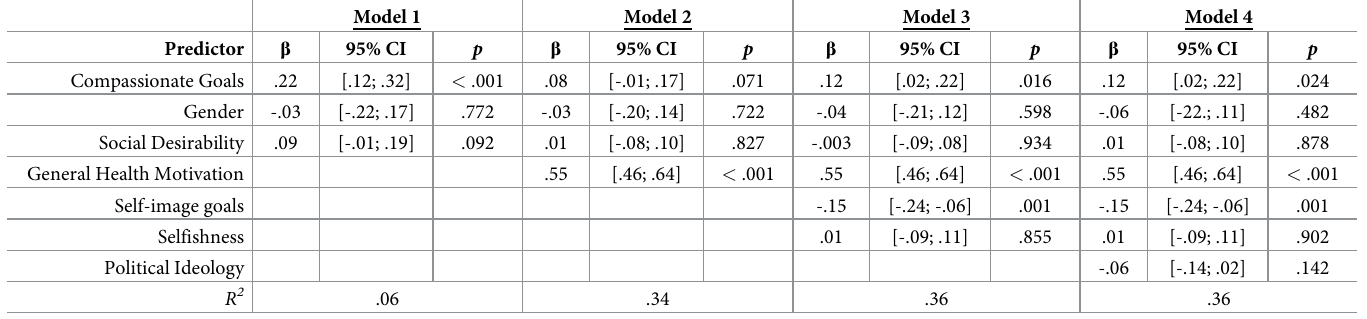
Table 8. Coefficients from multiple regression models predicting general health behaviors in Study